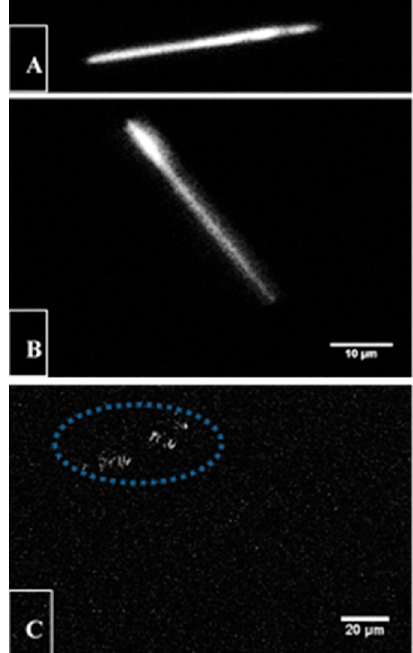
Figure 6. Microscopy characterization of CuHARS dried films. CuHARS were applied to 48-well culture plates as for AgCysNPs, and then imaged using brightfield microscopy with 10× and 20× objectives ( A , B , respectively). Additionally, zoomed areas were imaged using bright-field, polarization, and phase microscopy (panels C – E , respectively). Scale bars in upper left of each image indicate 100 microns for panels A , B , and 50 microns for panels C – E .